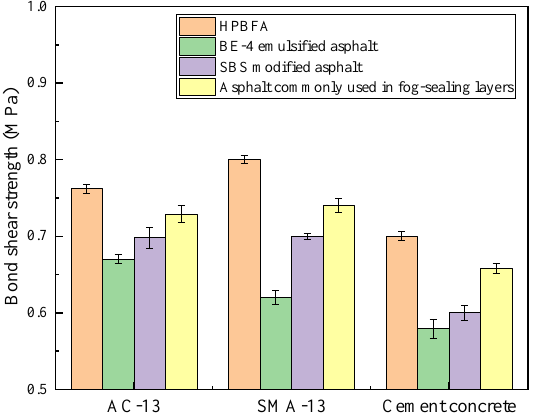
Figure 12. Bonding properties of various fog-sealing adhesive materials.